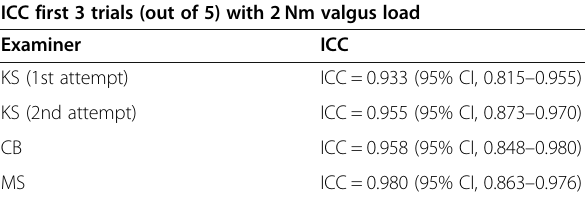
Table 2 Intraclass correlation coefficient of first 3 out of 5